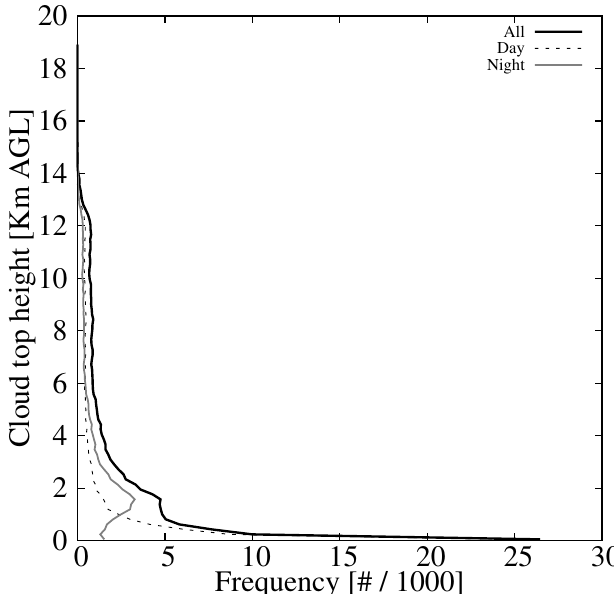
Figure 12. Histogram of the cloud top height for the over-detected clear skies from the ACHA product for both day and night retrievals (black solid line), daytime retrievals (black dashed line), and nighttime retrievals (gray solid